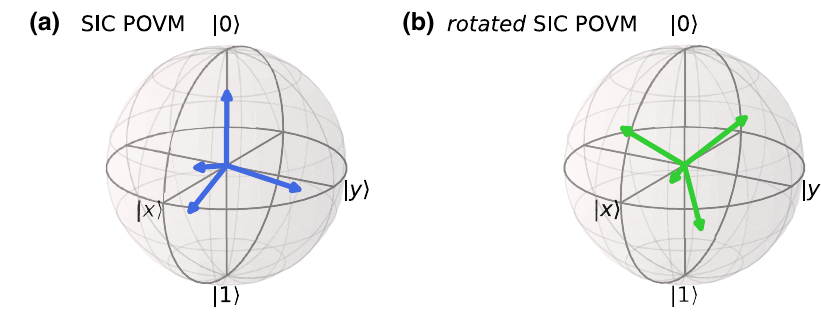
FIG. 15. Various representations of SIC POVM for maximizing information gain. (a) Standard representation of SIC POVM as used throughout this manuscript in both experiments and numerical simulations. (b) Rotated SIC optimized for predicting Pauli